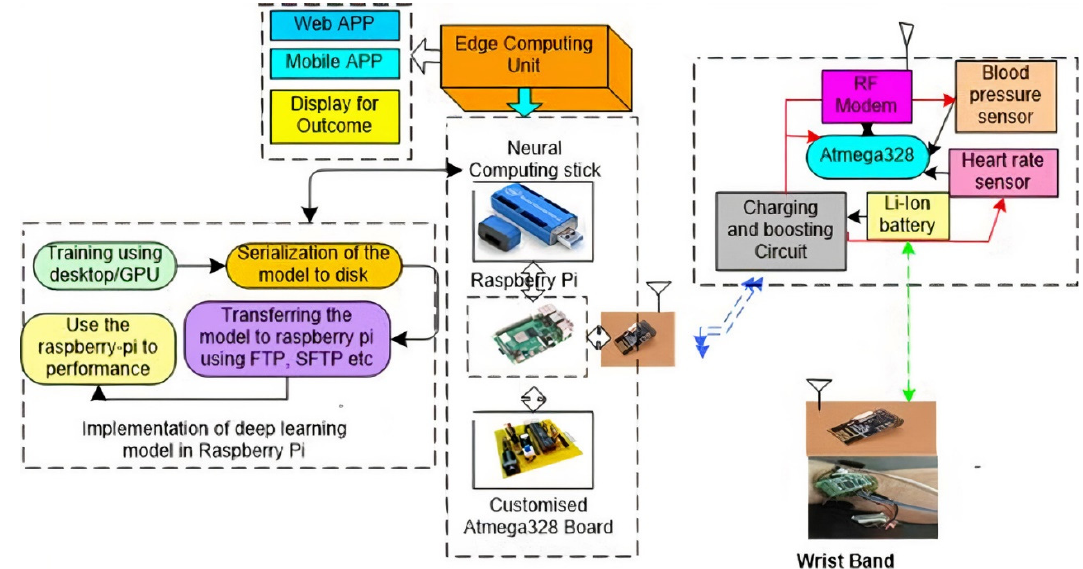
Figure 1. A conceptual framework of the proposed study.